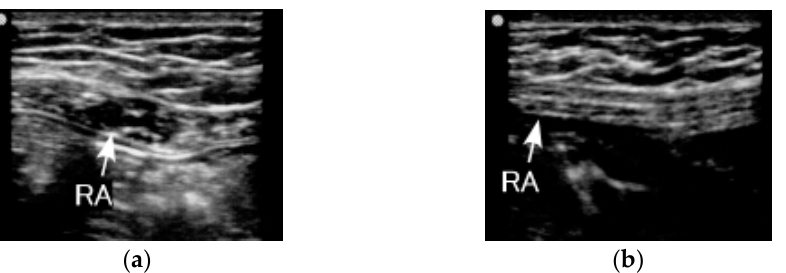
Figure 1. Rectus abdominus (RA) of a perinatal woman. The “wave-like” shape can be observed in the ( a ) image. ( a ) This image was taken one month after delivery; ( b ) this image was taken four months after delivery.